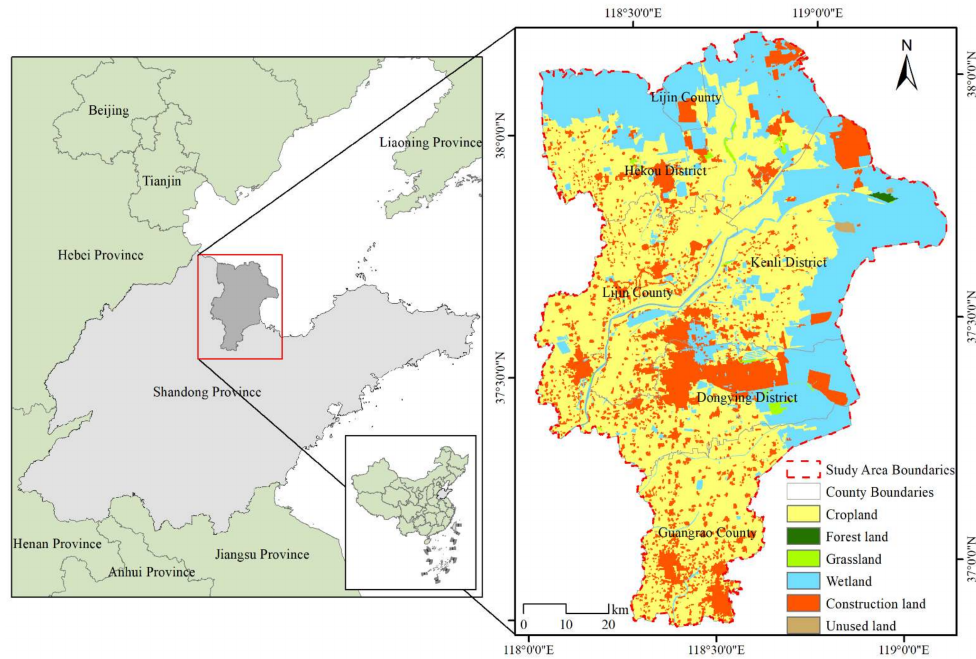
Figure 1. Geographical location and land cover of study area.